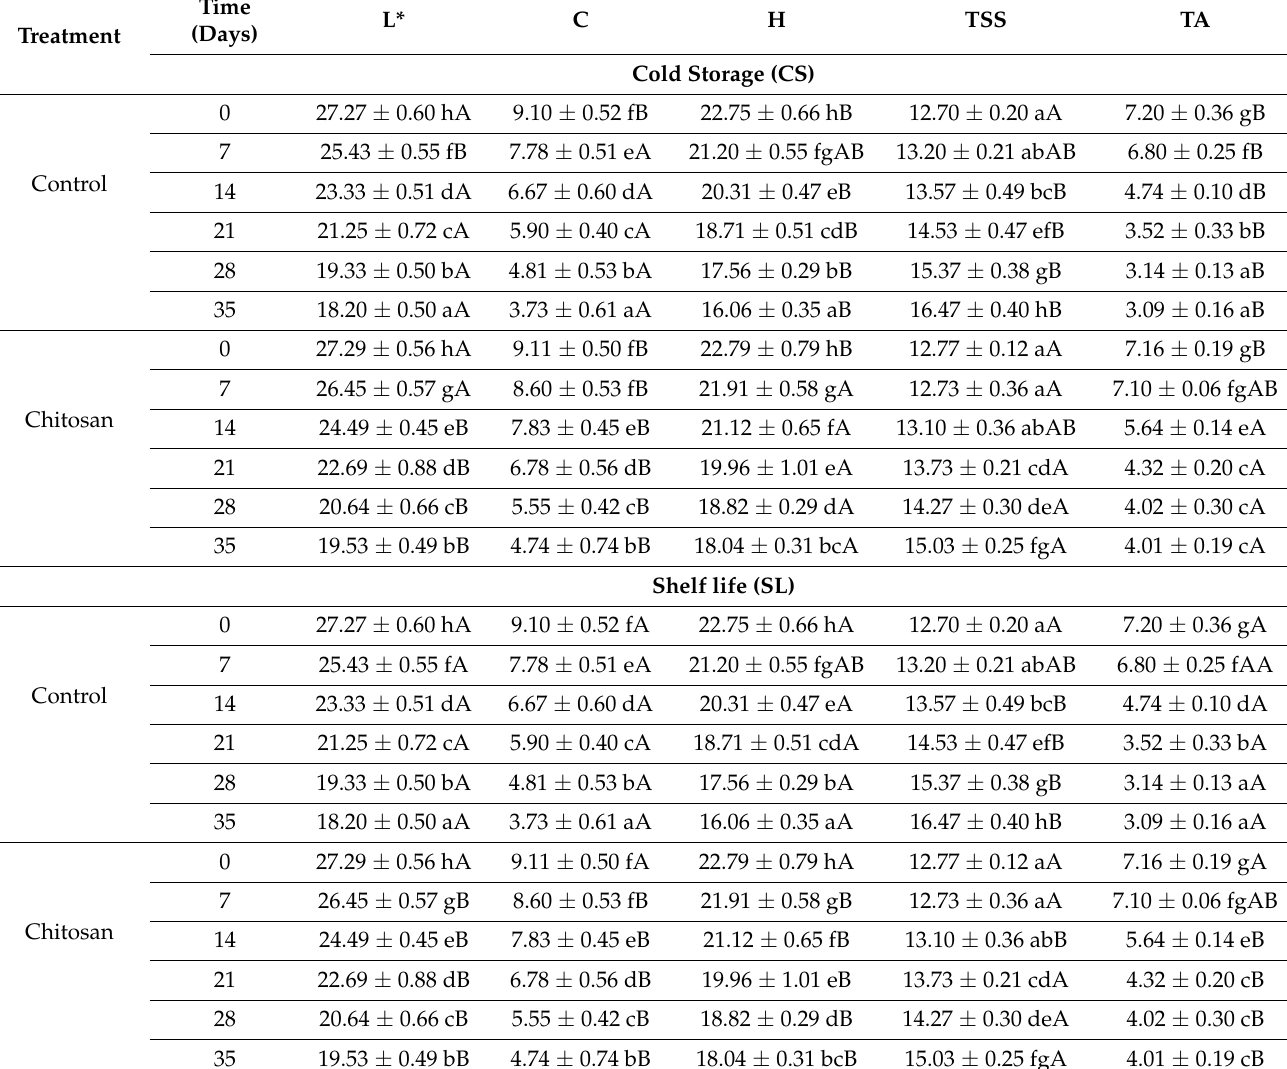
Table 1. Colorimetric parameters (L*: lightness; C: Chroma; H: Hue angle), total soluble solids (TSS: ◦ Brix) and titratable acidity (TA; g malic acid per L juice) at harvest (0) and after 7, 14, 21, 28 and 35 days of cold storage followed by 3 days of shelf life for chitosan-coated (Chitosan) and uncoated fruit